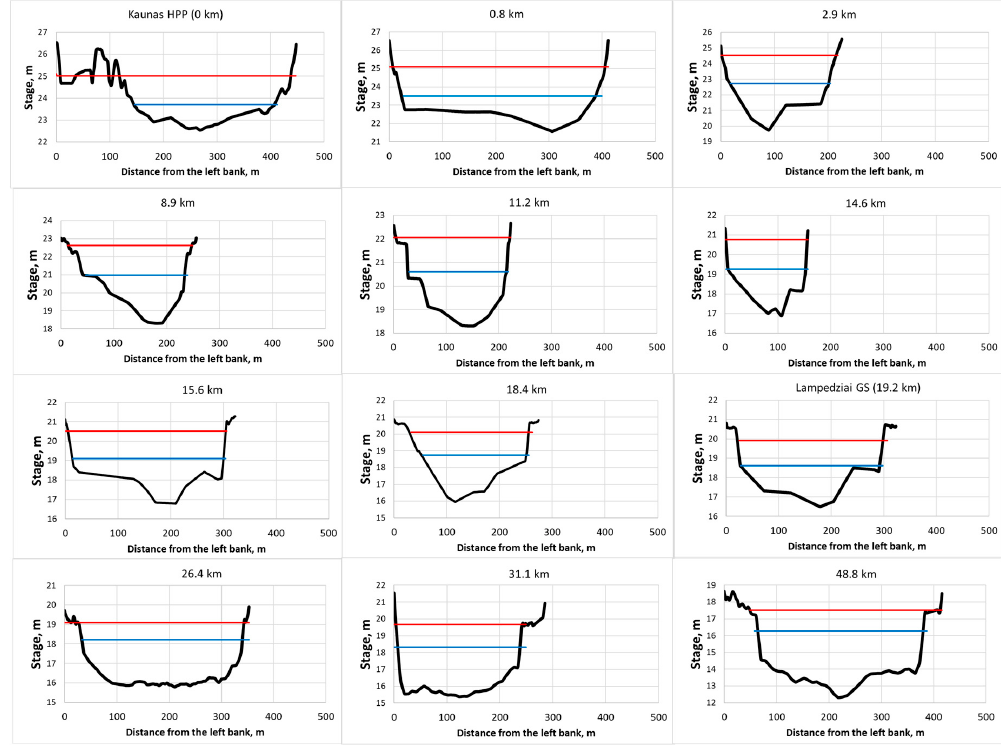
Figure 7. Cross-sections of Nemunas River channel at temporary stage measurement sites and gauging stations in 2015. Two last cross-sections, 31.1 and 48.8 km distance from Kaunas HPP, were taken in 2016. Red lines show maximum river stage, blue lines, minimum stage.